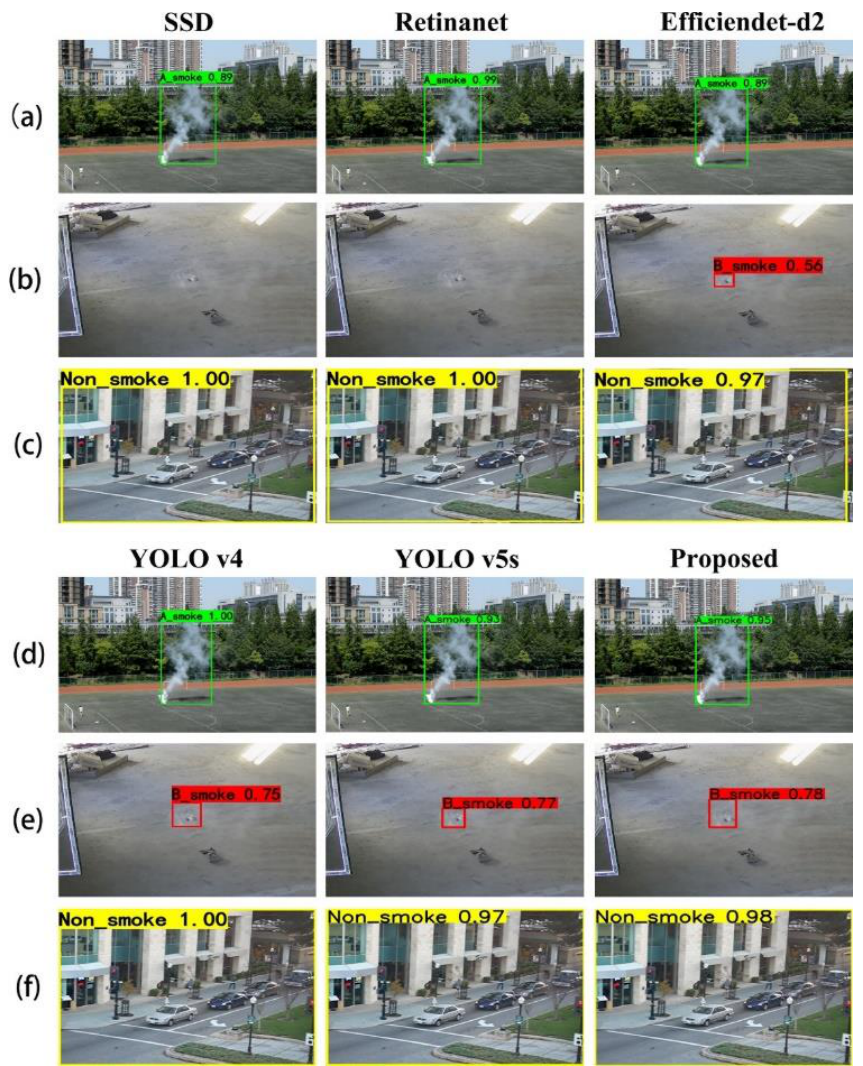
Figure 8. Detection results. ( a , d ) The detection result of smoke; ( b , e ) the detection result of small and thin smoke; ( c , f ) The detection result of